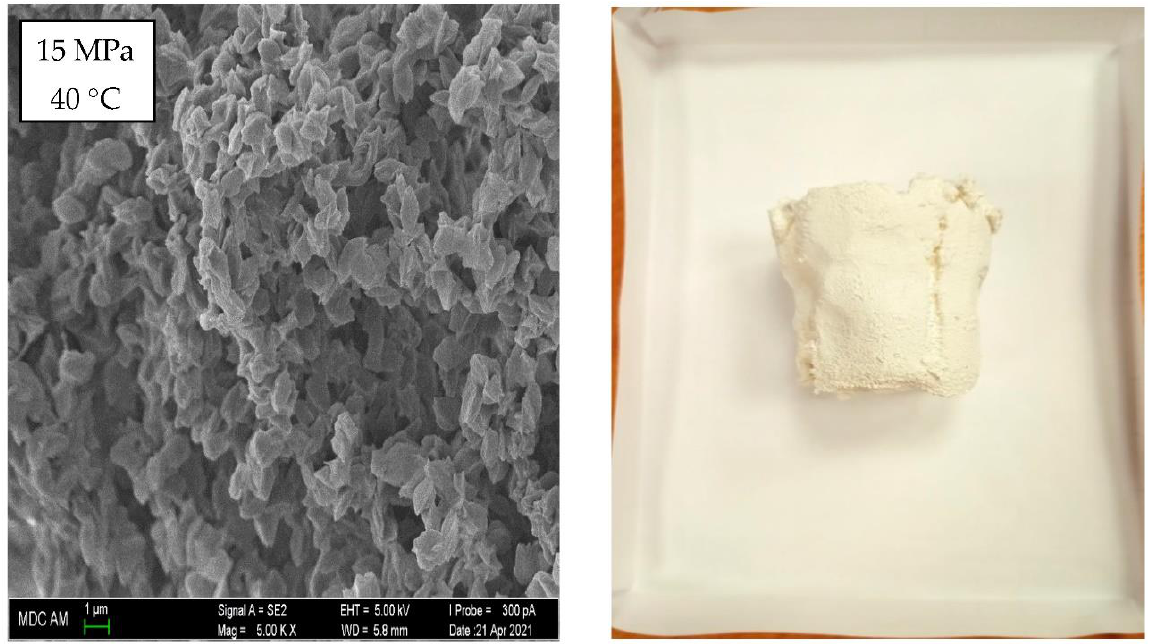
Figure 3. SEM image (phase morphology, left ) of the polymer blend microparticles with a composition of PP-01030 (75%)/EPTSR-50 (25%) and photo ( right ) produced by SEDS at a temperature of t = 40 ◦ C and pressure P = 15 MPa (see Table 3, operating condition No. 4).